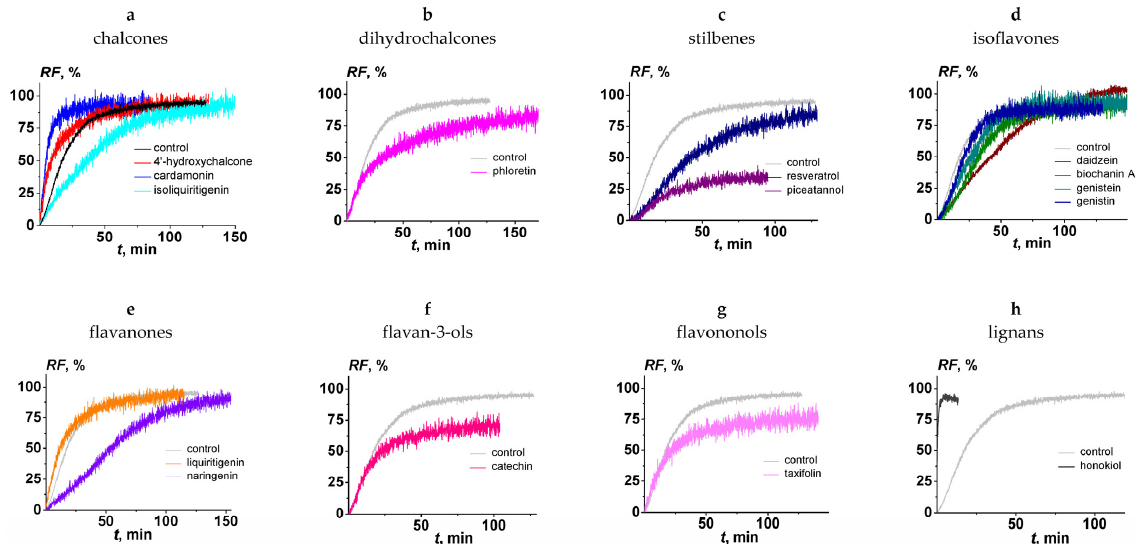
Figure 2. The time dependence of relative fluorescence of calcein ( RF ) leaked by the fusion of DOPC/DOPG/CHOL (40/40/20 mol.%) vesicles induced by 40 mM CaCl 2 in the absence (black line in figure ( a ) and grey in figure ( b – h ) and presence of polyphenols: ( a ) 4 ′ -hydroxychalcone, carda- monin, and isoliquiritigenin; ( b ) phloretin; ( c ) resveratrol and piceatannol; ( d ) daidzein, biochanin A, genistein, and genistin; ( e ) liquiritigenin and naringenin; ( f ) catechin; ( g ) taxifolin; and ( h ) honokiol. Liposomes were incubated with 20 µM polyphenols for 30 min before the addition of inductor. The relationship between the colored line and the polyphenols is given in the figure. Table 1. The parameters characterizing the effect of polyphenols on the calcein leakage at the fusion of the DOPC/DOPG/CHOL (40/40/20 mol.%) vesicles mediated by calcium. Polyphenol Group LogD #